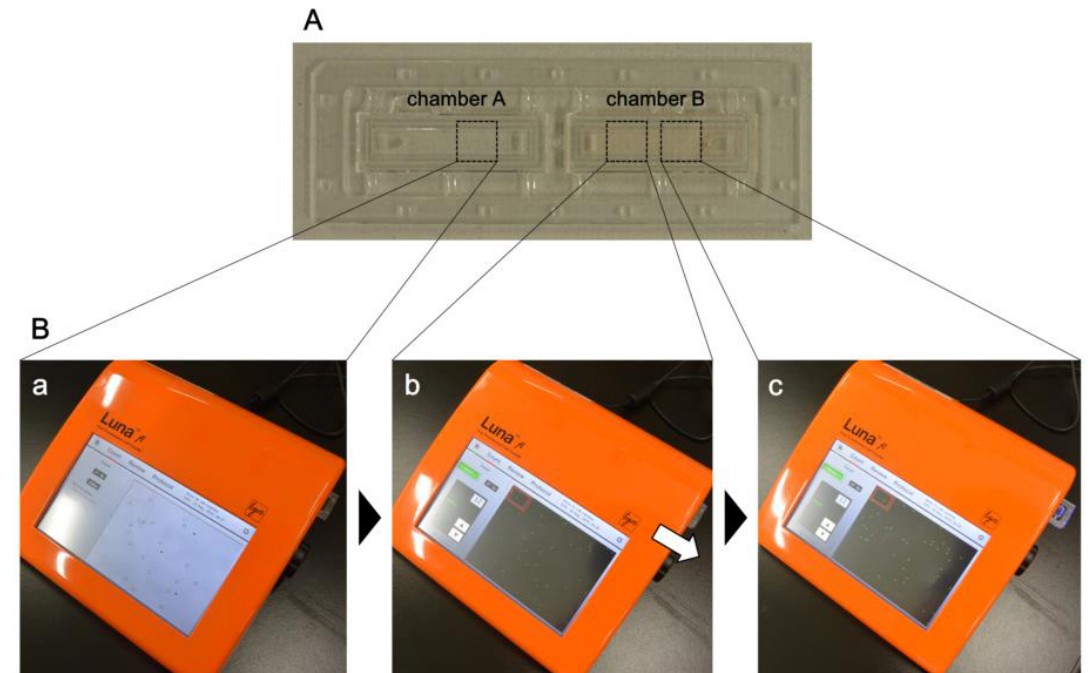
Figure 1. Methods for the estimation of parasitemia using LUNA-FL. ( A ) Photon slides were used for the detection of parasites using LUNA-FL. Blood samples diluted for erythrocyte counting were applied to Chamber A. Blood samples diluted and acridine orange (AO)-stained for parasite counting were applied to Chamber B. ( B ) First, bright-field images in Chamber A were captured, to adjust focus, followed by the counting of erythrocytes ( a ). Second, two fields of fluorescent images in Chamber B were captured to count the parasites ( b , c ). Parasitemia was estimated from the data obtained from Chamber A and Chamber B.